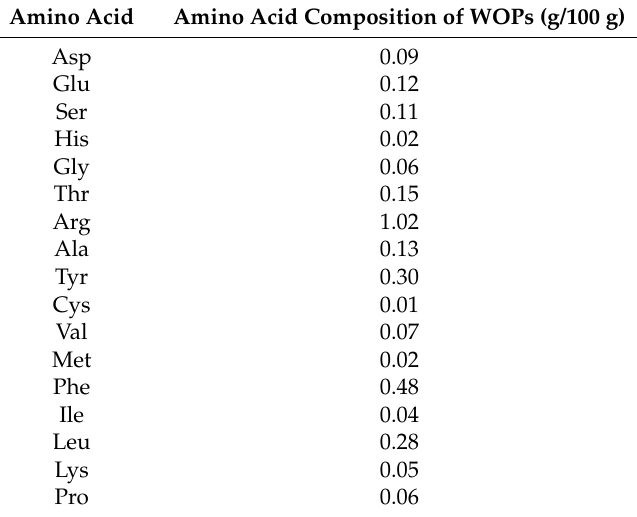
Table 4. Amino acid composition of